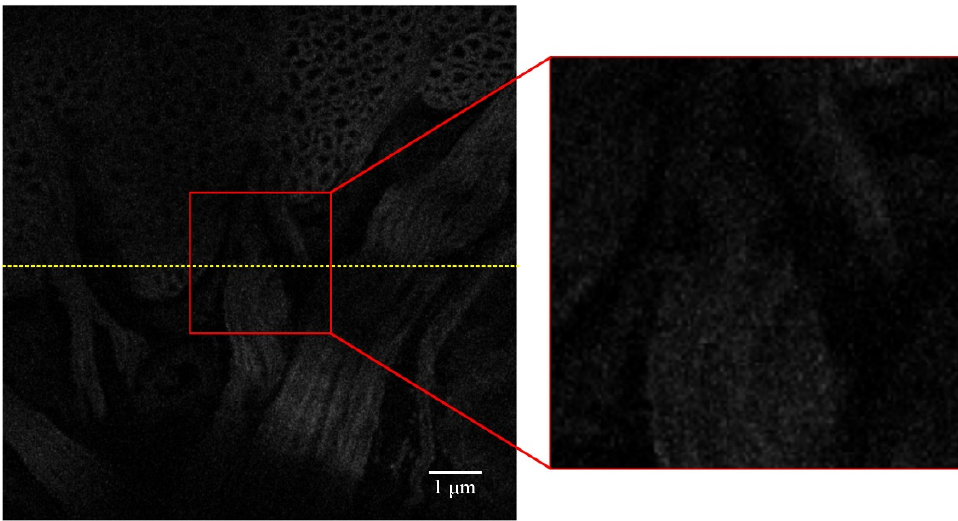
Figure 5. Initial imaging result of the specimen at − 0.0815 mm in the z ‐ axis direction, and the gray ‐ scale variance value is about 6.0.